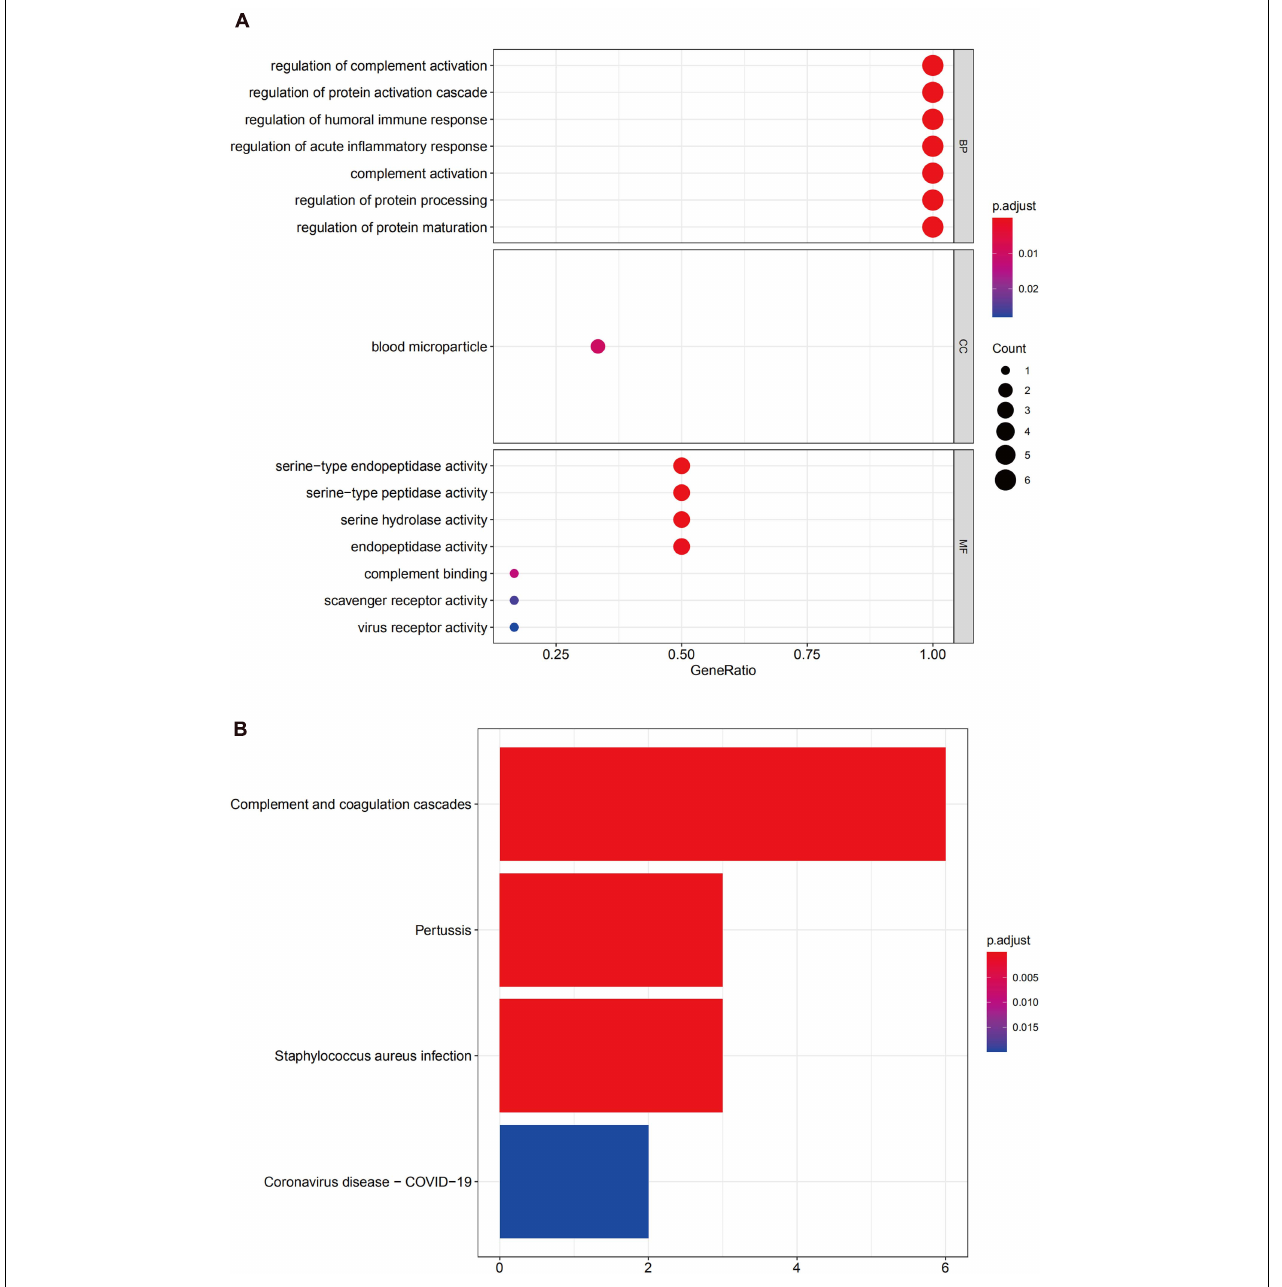
FIGURE 9 | Functional enrichment analysis for the genes in module 3 (A) GO analysis for DEGs. (B) The KEGG analysis for